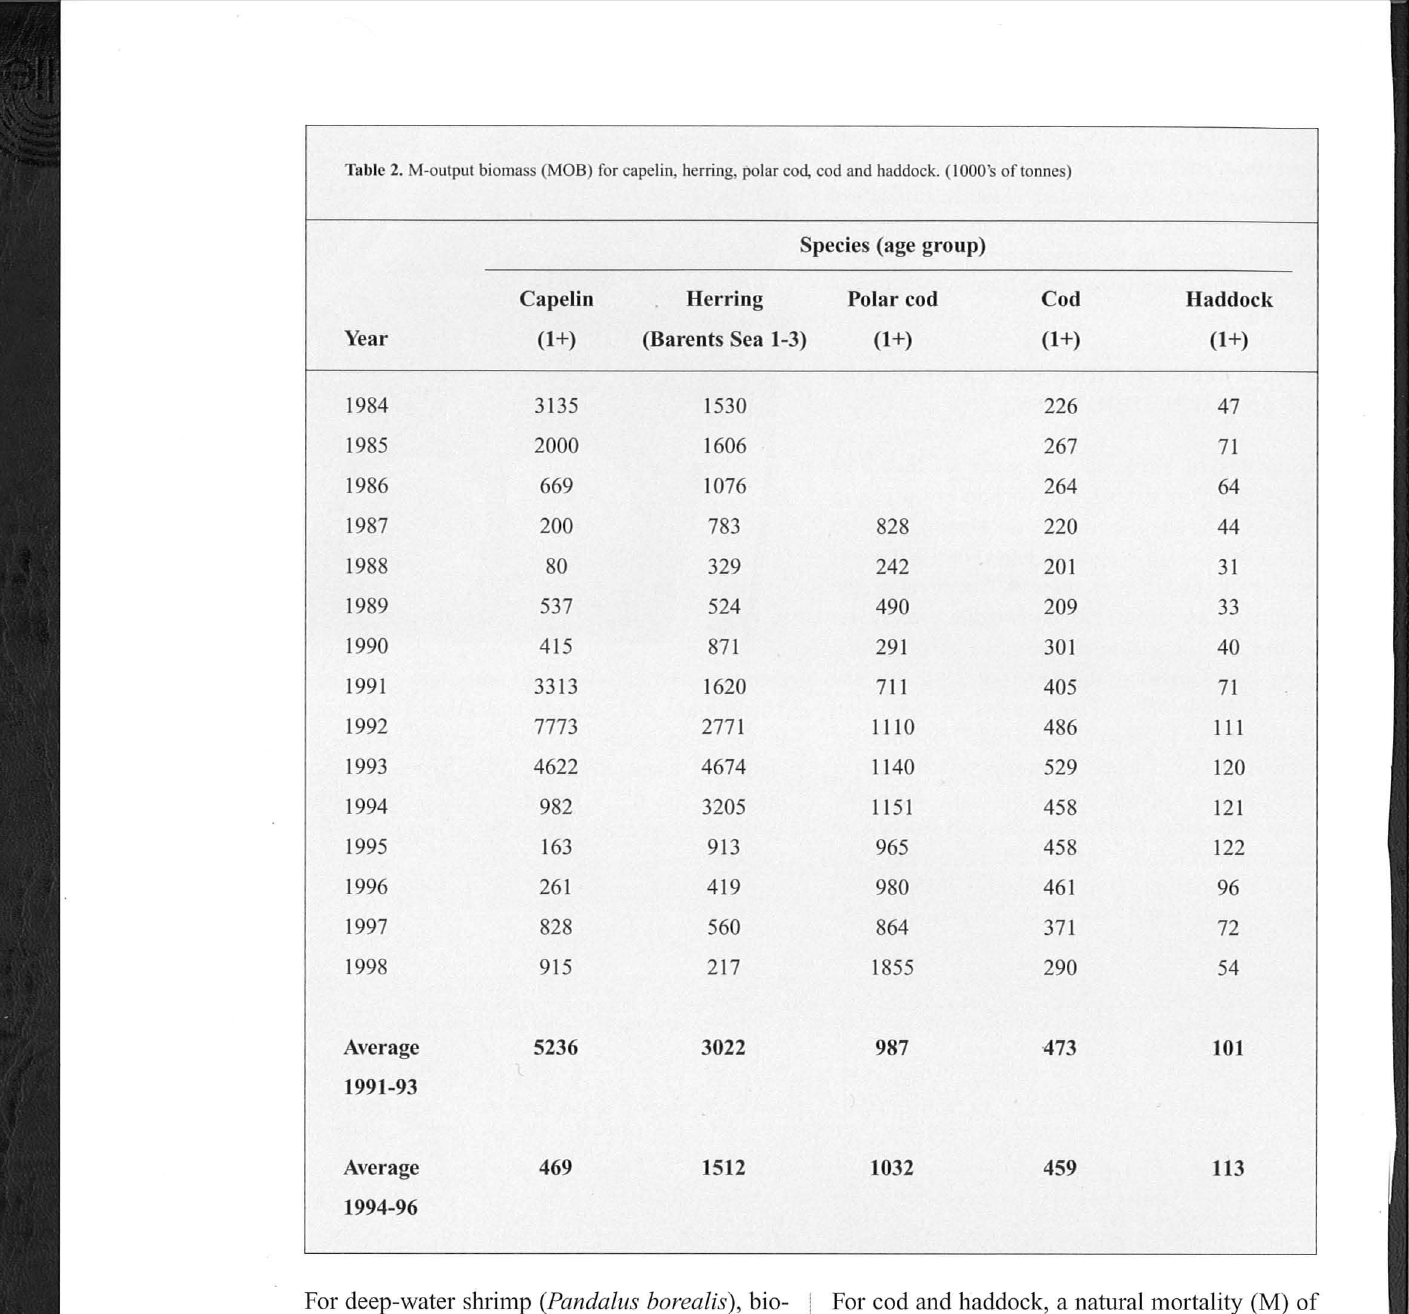
Table 2. M-output biomass (MOB) for capelin, herring, polar cod, cod and haddock. (1000's oftonnes)